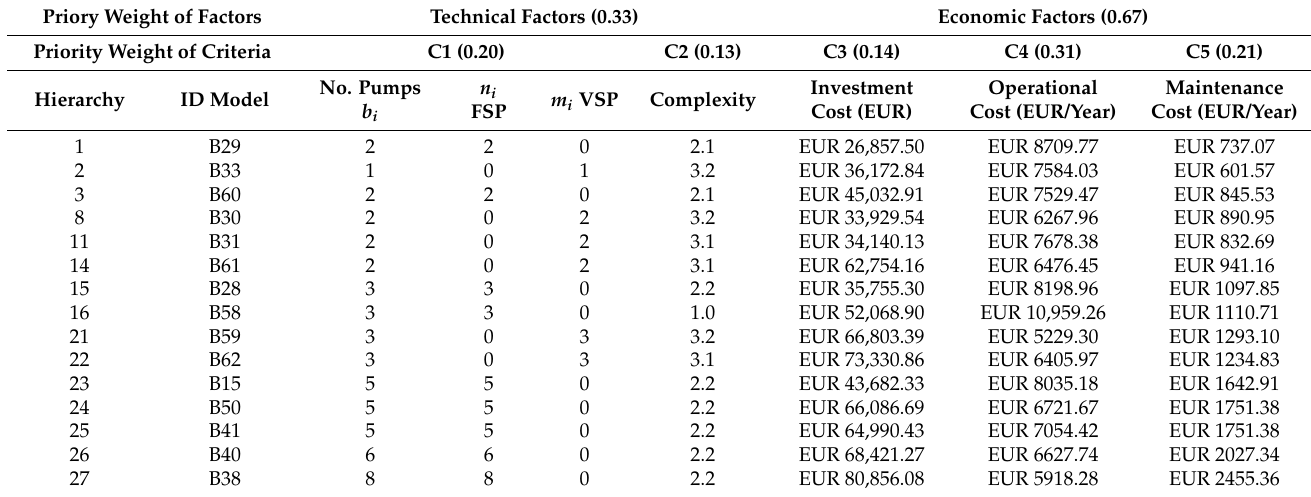
Table 12. Assessment of the criteria for each alternative (CAT-PS2).